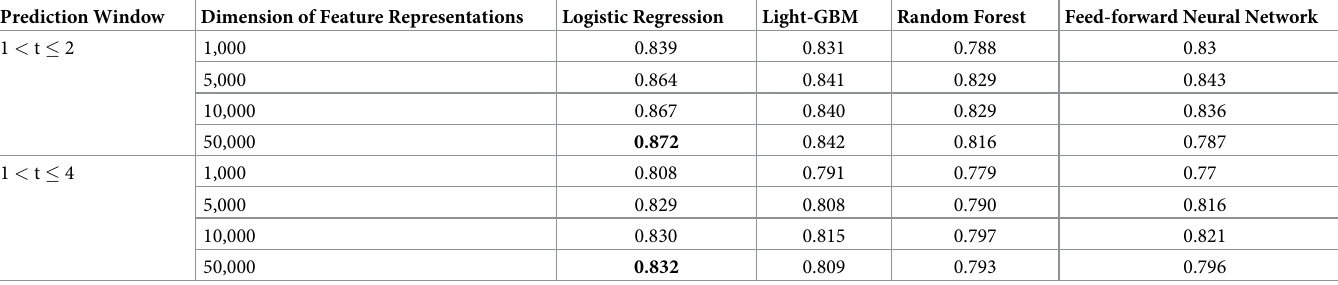
The columns show the comparison among the models, and the rows show the comparison among three variants of maximum features in TF-IDF. The bold numbers indicate the highest AU-ROC scores and the best performing models for both short-term prediction